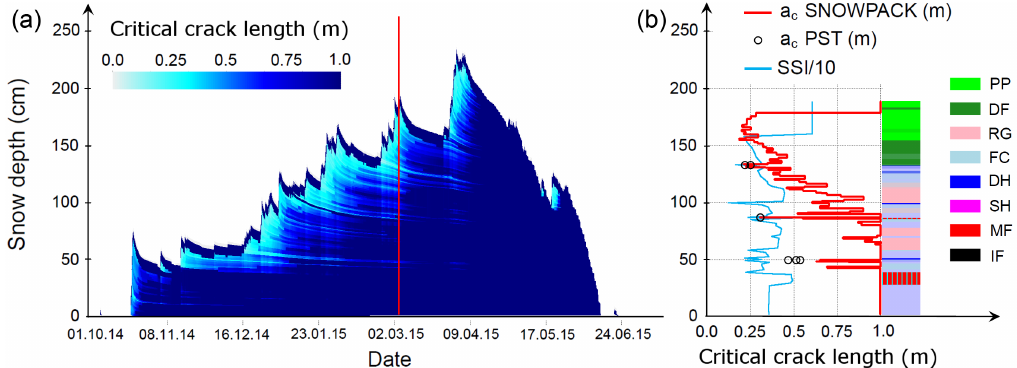
Figure 9. (a) Seasonal profile of the simulated critical crack length (winter 2014–2015) at Steintälli (Davos, Switzerland) on the flat. (b) Ver- tical profile of the critical crack length (modeled and from field PSTs) and SSI/10 for the date marked by the vertical red line in (a) . The grain type is shown on the right following Fierz et al.